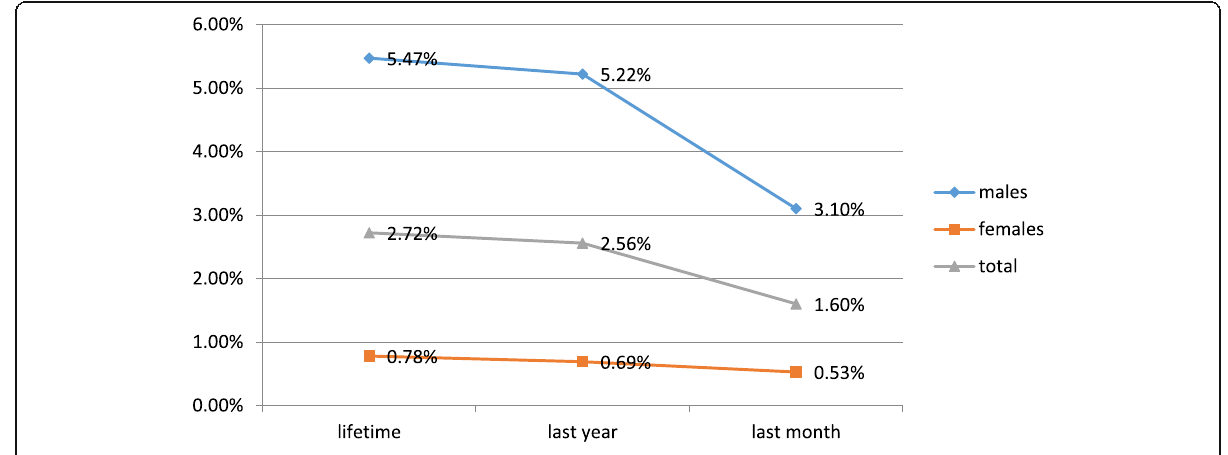
Fig. 5 Self-reported lifetime, last 12 months, and last 30 days prevalence of cannabis